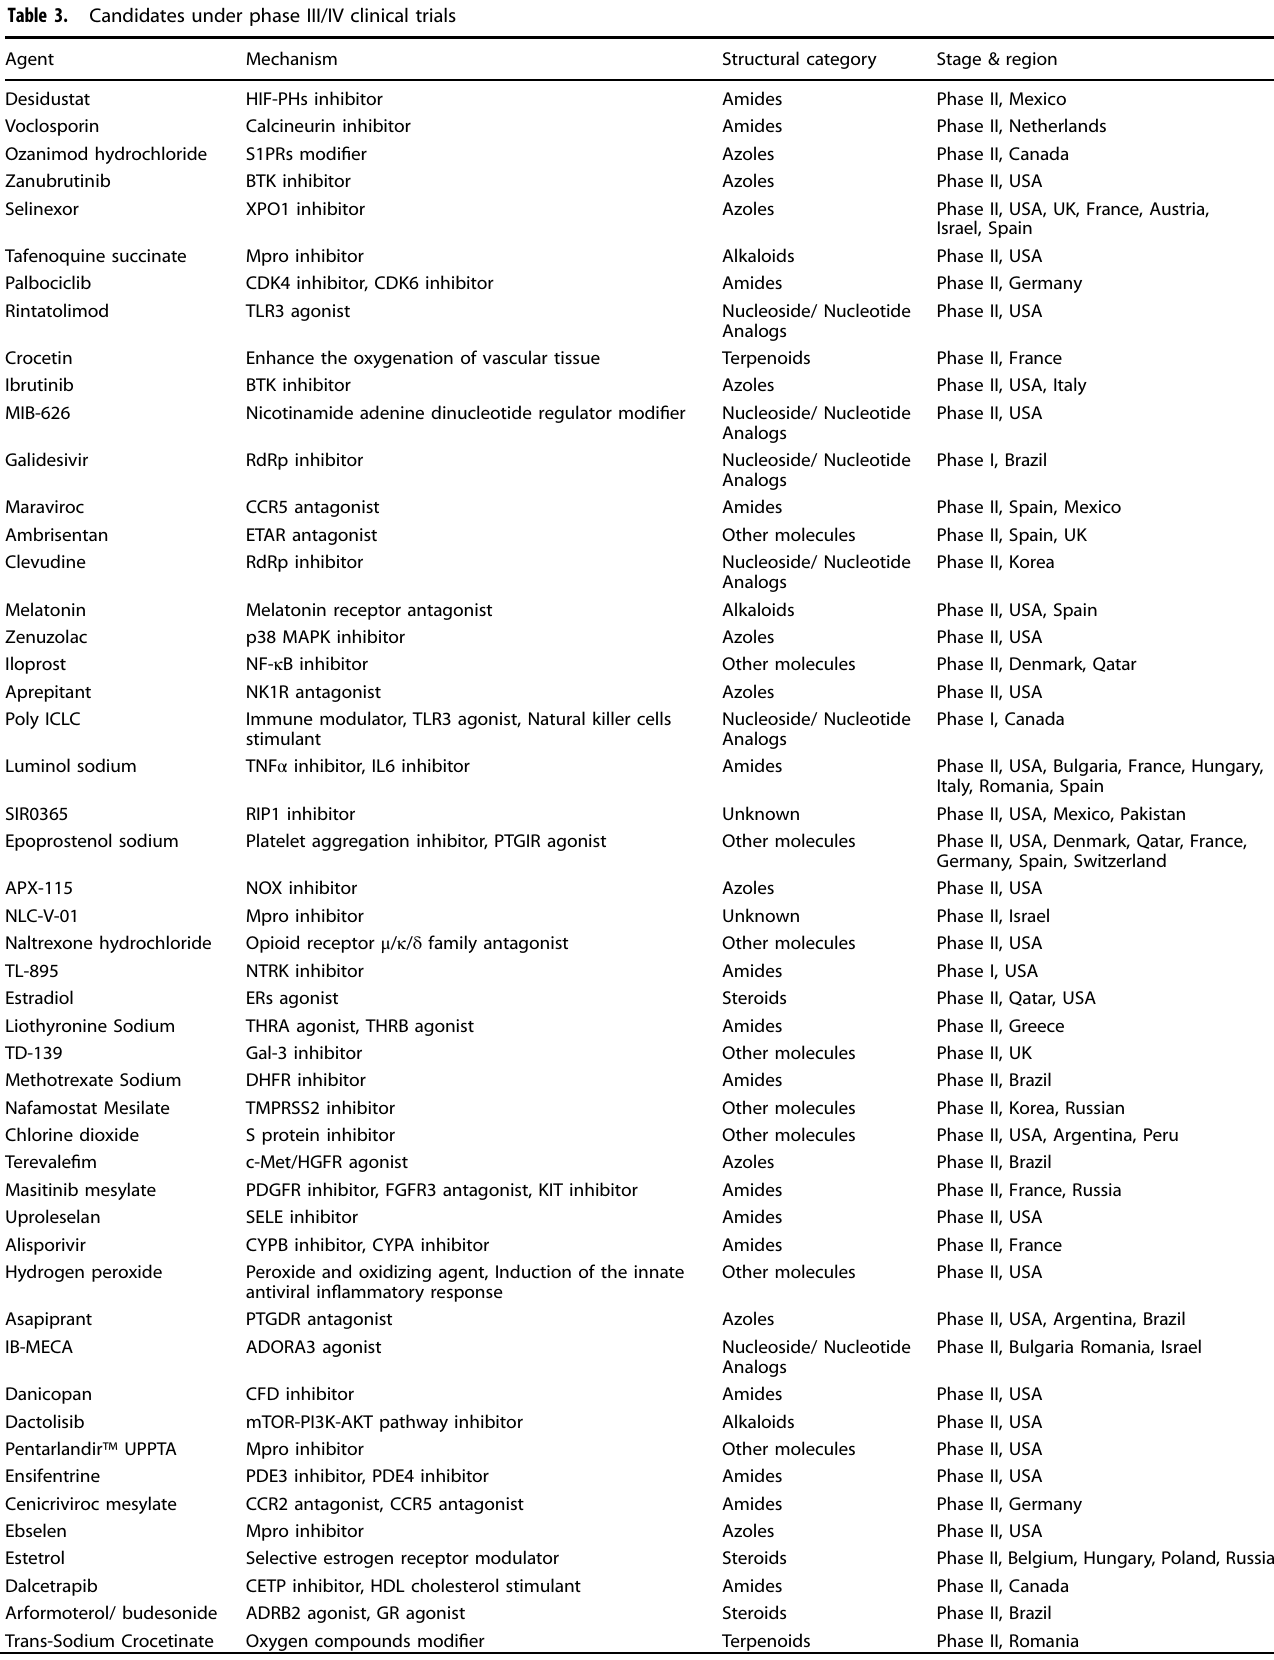
Table 3. Candidates under phase III/IV clinical trials